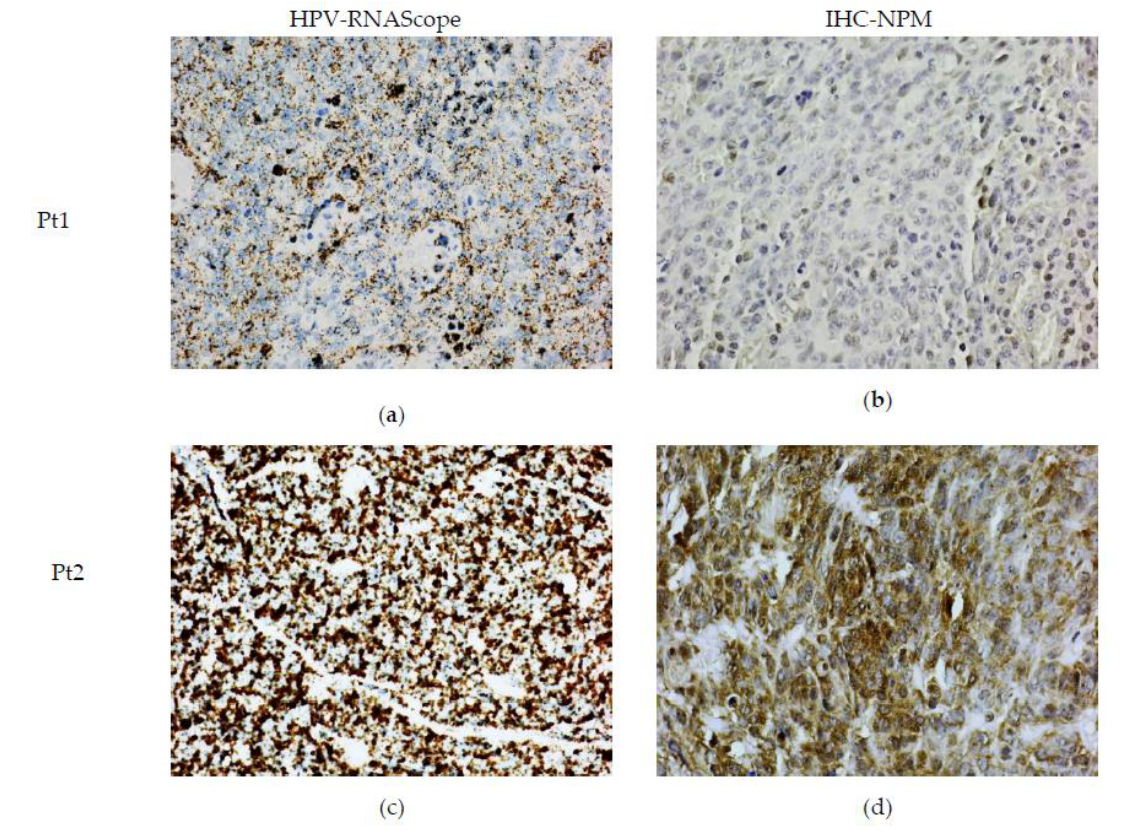
Figure 2. HR-HPV ISH and IHC of NPM protein in OPSCC ( a , c ) RNAScope ISH showing mild/moderate and large amounts of E6/E7 mRNA HR-HPV, respectively, ( b , d ) representative images of NPM IHC staining of same patients (Pt1, Pt2) depicted in ( a , c ). Weak and intense staining correlates with the amount of E6/E7 mRNA.